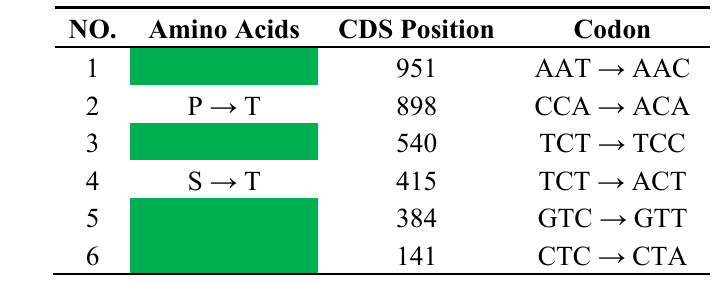
Table 2. SNPs of